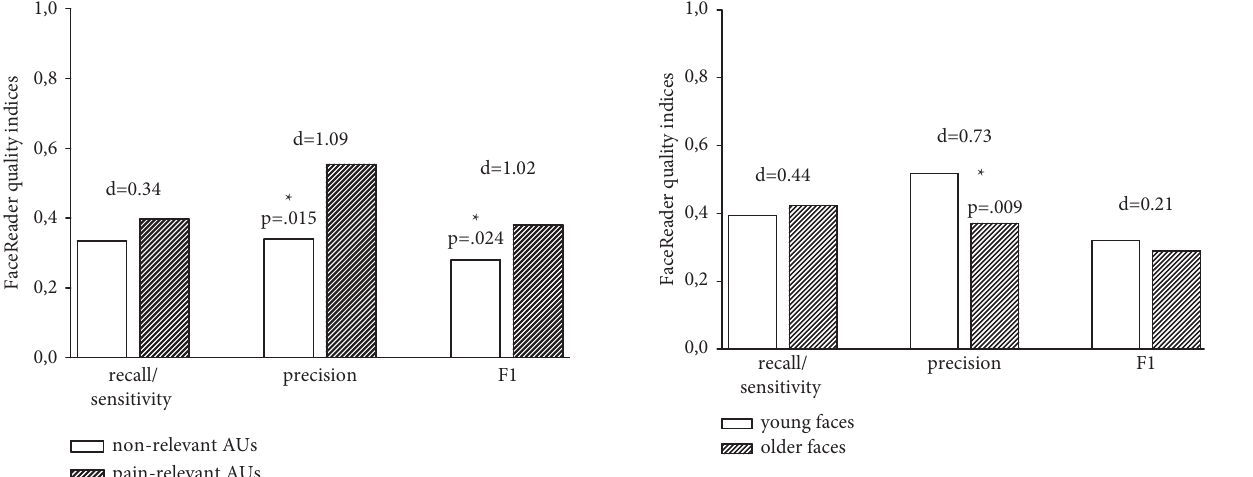
Figure 2: FaceReader7 performance in dependence of whether AU detection was performed in younger (20–39 years) or older (40–60 years) individuals. ∗ p < 0 . 05; d � effect size, Cohen ’ s d